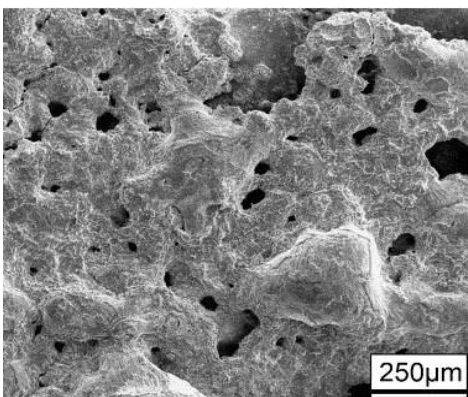
Figure 6. Pores in the W–Cu components by DMLS. Reproduced from [46]. with permission from Figure 6. Pores in the W – Cu components by DMLS. Reproduced from [46]. with permission from Figure 6. Pores in the W – Cu components by DMLS. Reproduced from [46]. with permission from Elsevier, Elsevier, 2009. Elsevier, 2009. Figure 6. Pores in the W – Cu components by DMLS. Reproduced from [46]. with permission from Elsevier, 2009.